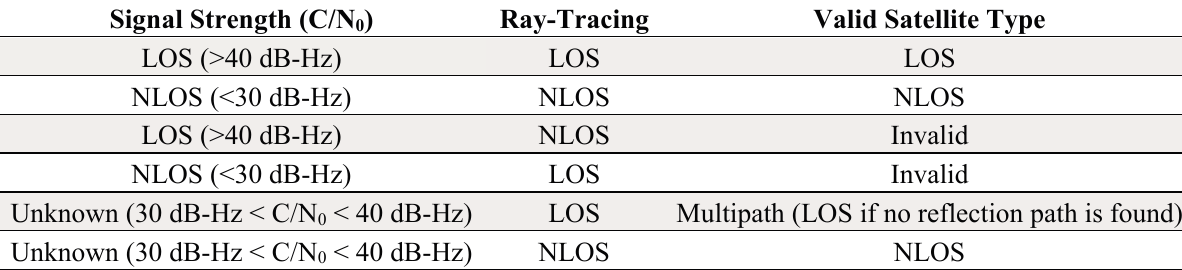
Table 1. Rule of signal classification for a candidate based on signal strength and ray-tracing [25].